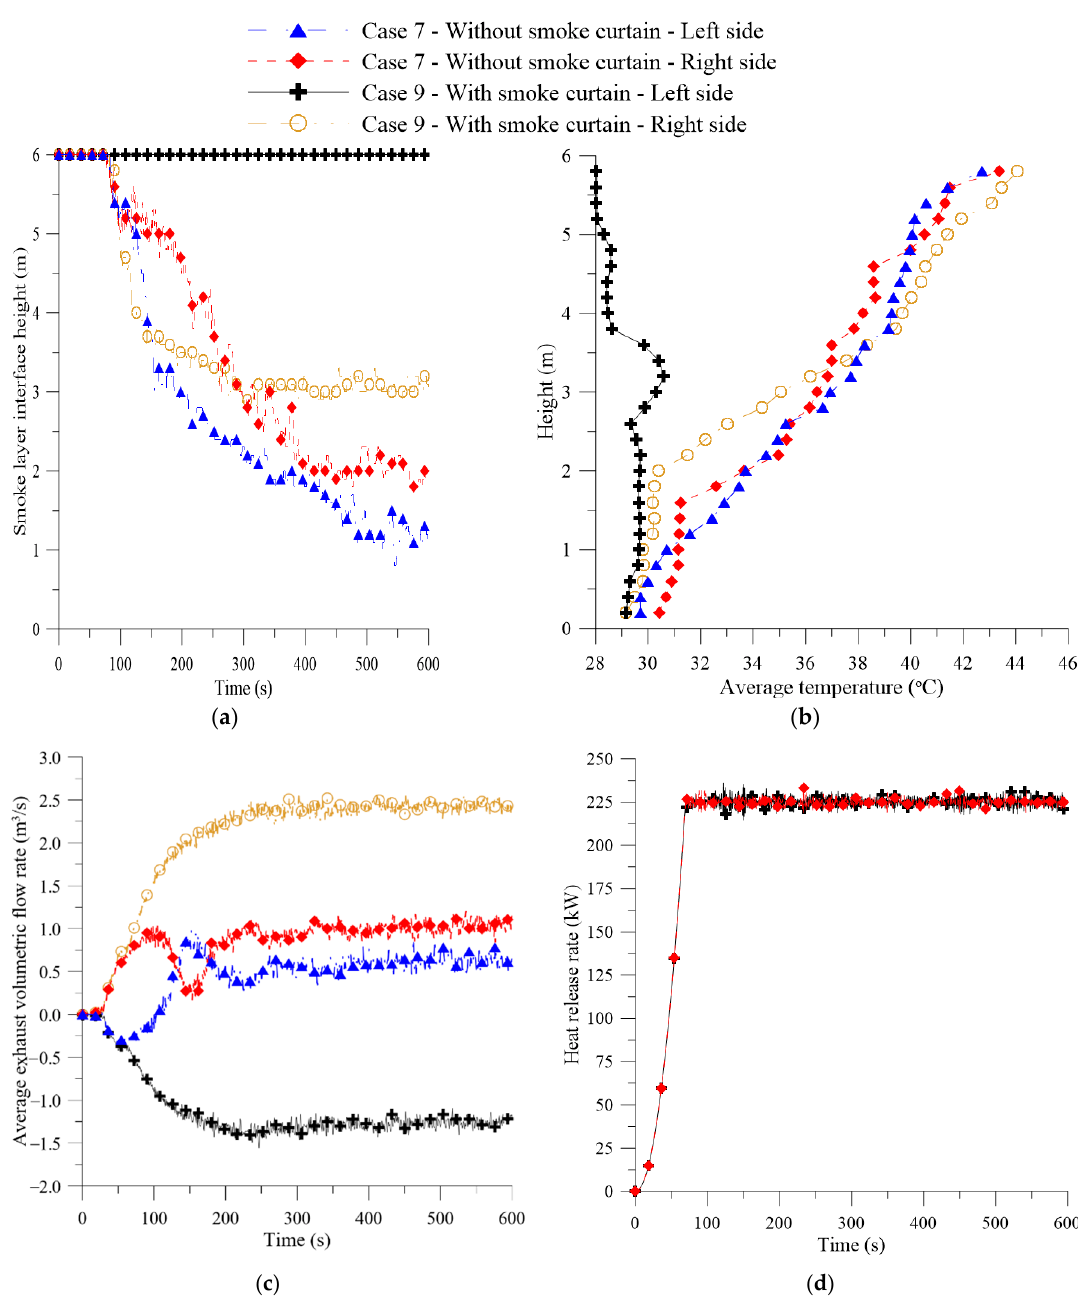
Figure 10. Influence of the smoke curtain in the ( a ) smoke layer vertical displacement; ( b ) average temperature profile at t = 600 s; ( c ) average exhaust volumetric flow rate and ( d ) HRR (compartments with natural exhaust areas of 9.00 m 2 , closed windows and HRR = 225 kW).